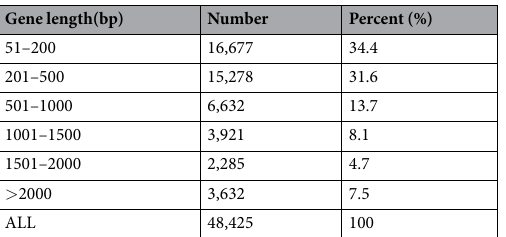
Table 2. The length distribution of coding sequence (CDS) predictions. For 48,425 of the predicted full-length coding sequences (CDSs), the size distribution can be divided into six species. The total number and the percentage of all genes are presented in the table.